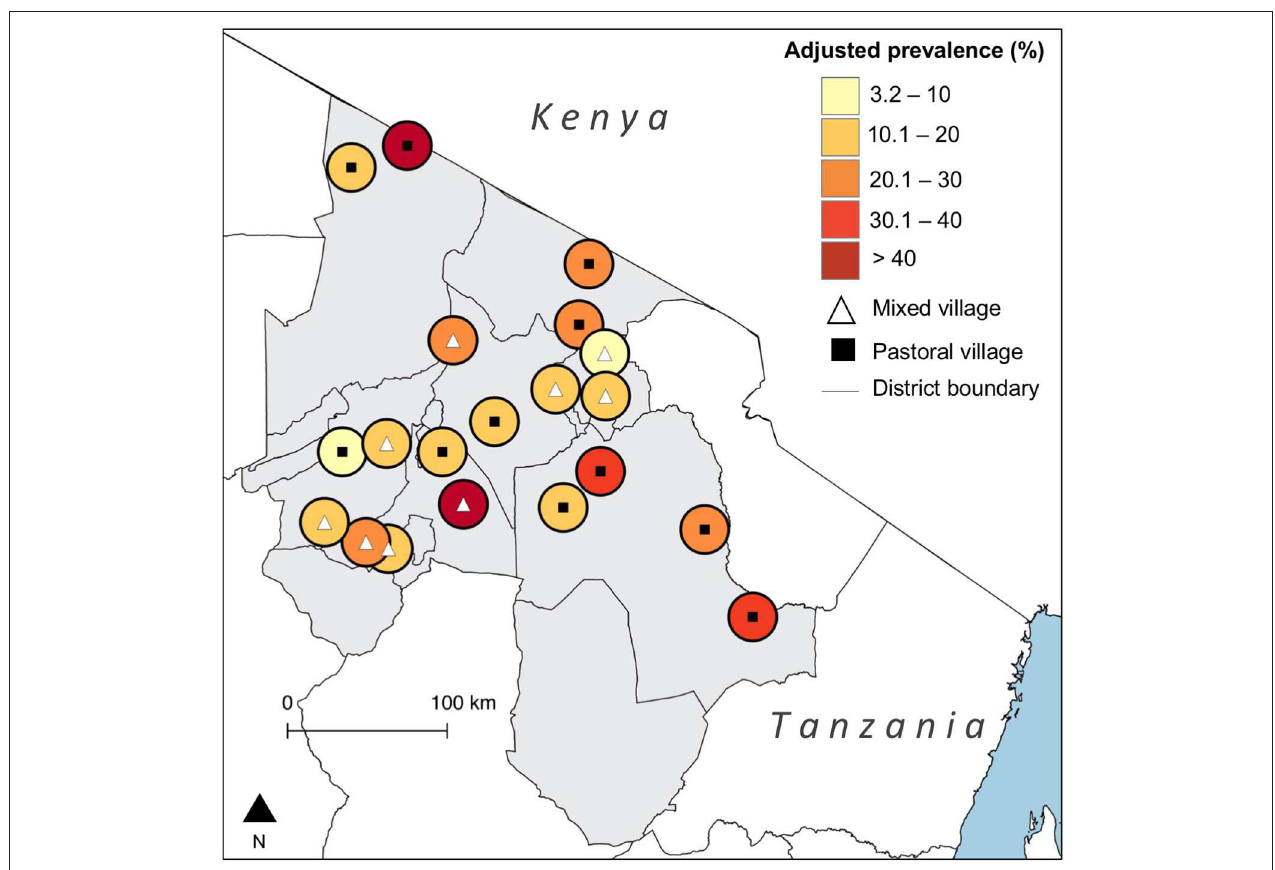
FIGURE 1 | Map showing the village-level prevalence of Neospora caninum seropositivity in northern Tanzania with adjustment for diagnostic test performance. (Created using QGIS version 2.14.3, shapefiles from https://gadm.org/).